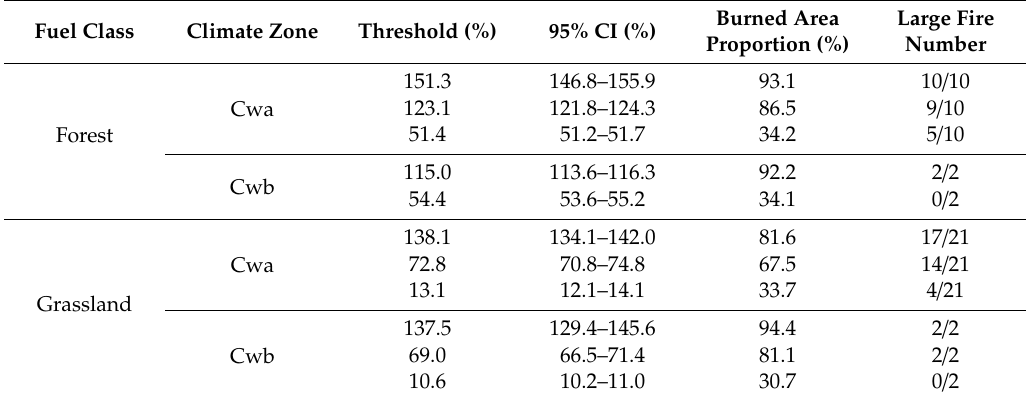
Figure 6. Relationship between pre-fire LFMC and cumulative burned area for forest ( a ) and grassland ( b ) across the Cwa climate zone, and forest ( c ) and grassland ( d ) across Cwb. Table 2. Value and range of critical LFMC thresholds, and proportion of burned area and the number of large fires below the corresponding threshold for forest and grassland across Cwa and Cwb zones.